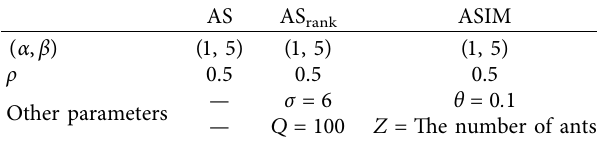
Table 2: Simulation condition and parameter